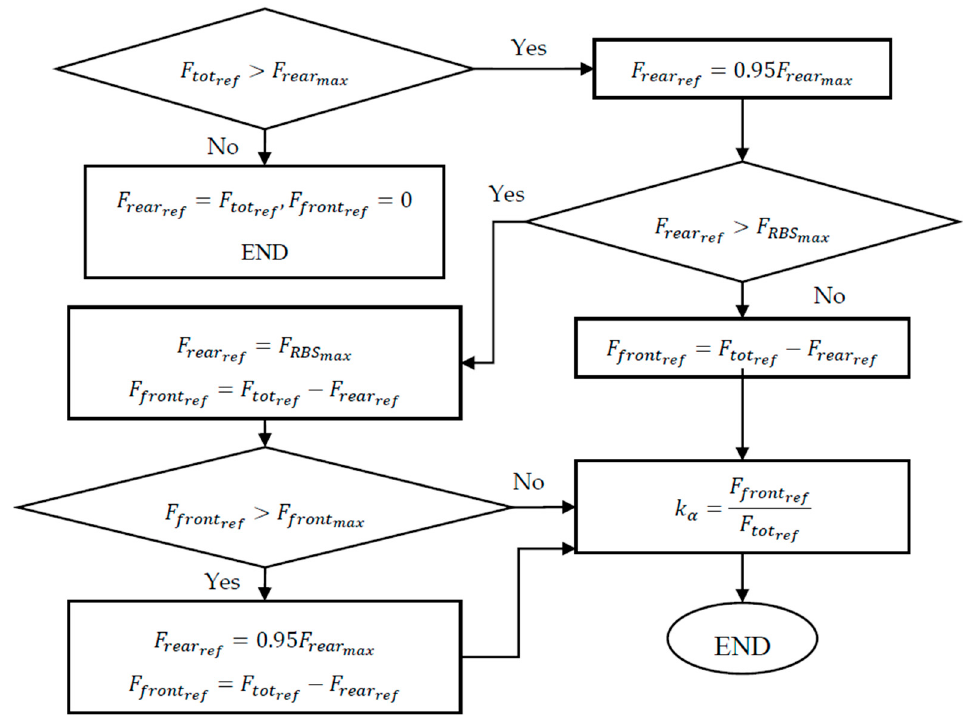
Figure 7. Braking strategy proposed.